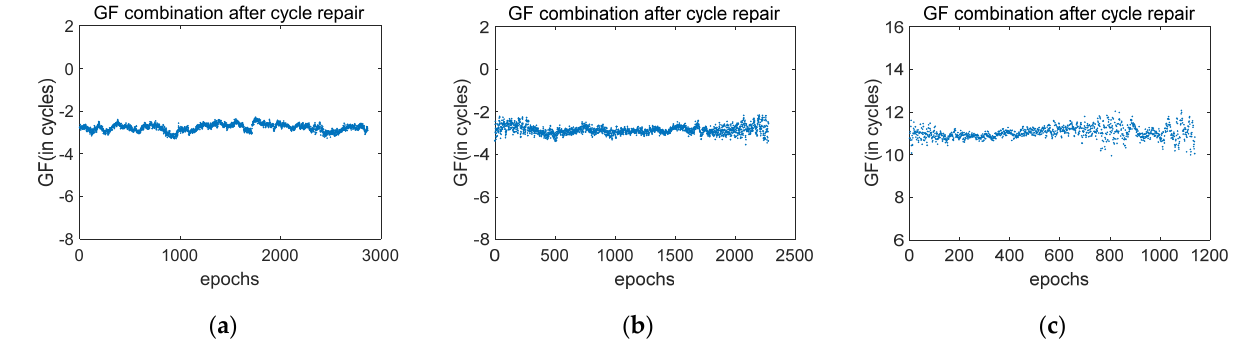
Figure 4. GF combination values after cycle slips were repaired.